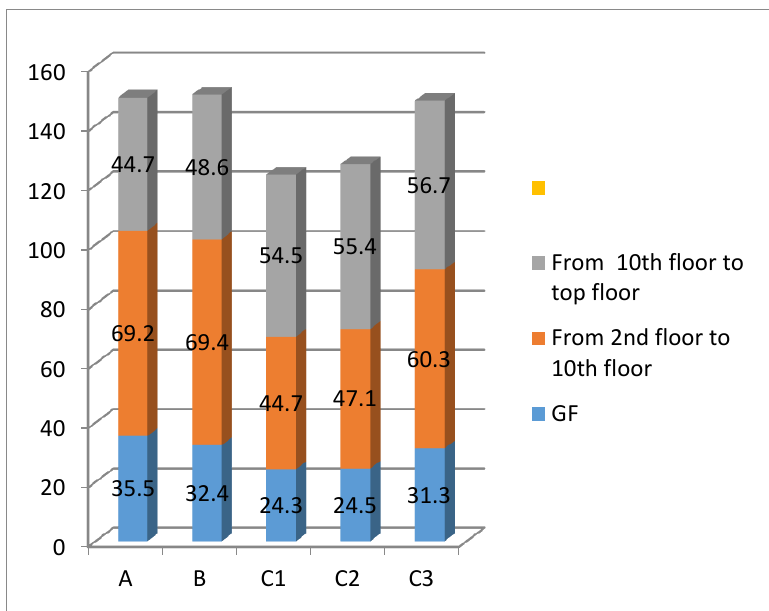
Fig. 6. Floor wise displacement of